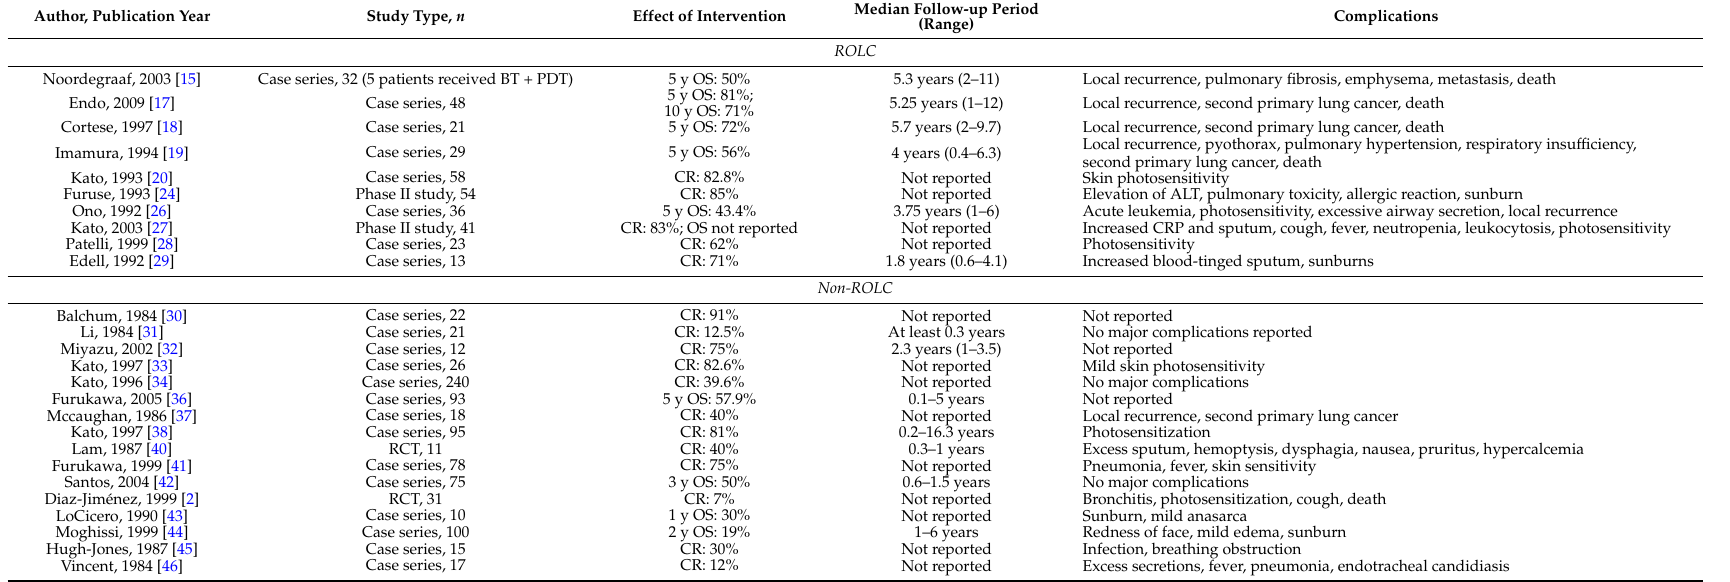
Table 1. Summary of primary studies on PDT in non-small cell lung